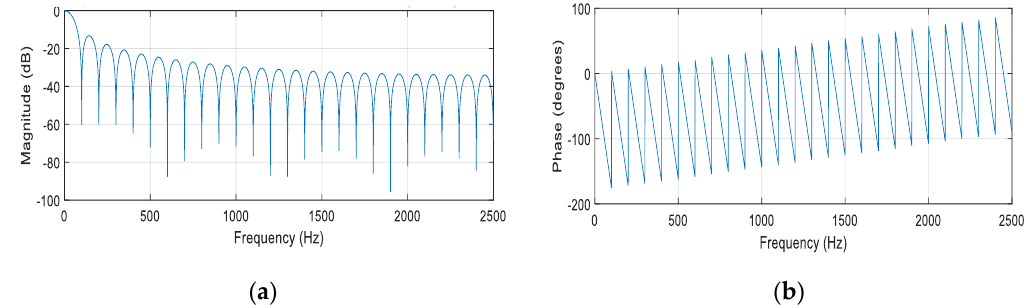
Figure 3. Amplitude — ( a ) and phase — ( b ) frequency characteristics of MAF filter. Using of digital infinite impulse response filter (DIIR) can lead to instability [15,16]. On the other hand, its advantage can be better (faster) attenuation of higher harmonics [11]. A comparison of power waveforms worked out by MAF-, DFIR and DIIR filters in the time domain is shown in Figure 4a,b, respectively.